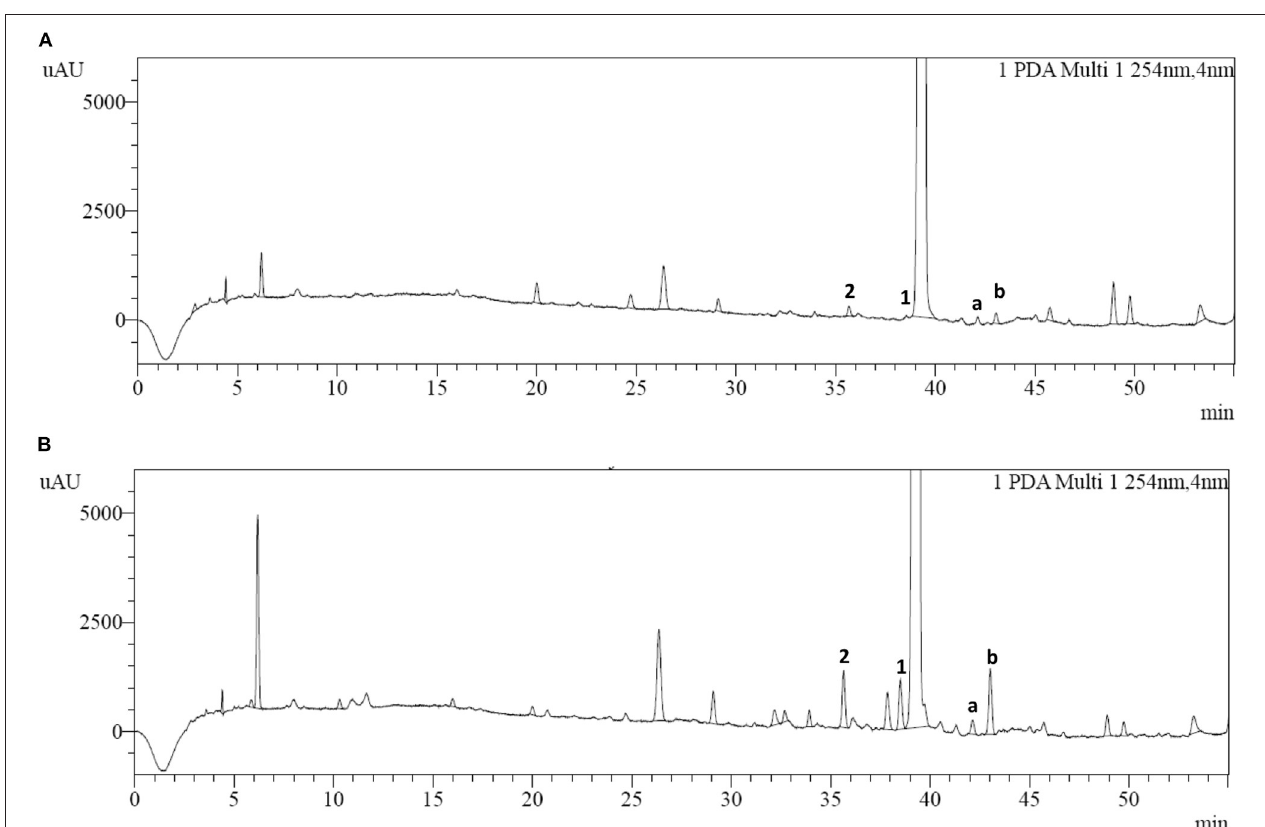
FIGURE 3 | HPLC chromatograms of (A) cefotiam hydrochloride and (B) the long-term-stability sample of cefotiam hydrochloride preparation.